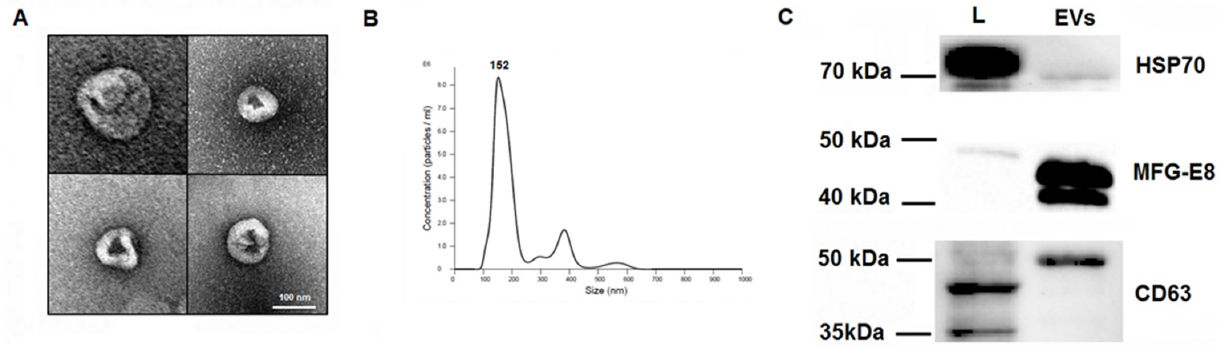
Figure 1. Characterization of extracellular vesicles (EVs) isolated from stem cells from the dental pulp of human exfoliated deciduous teeth (SHEDs). ( A ) Transmission electron microscopy of EVs isolated from SHEDs (120,000x magnification). ( B ) Concentration and particle size of EVs derived from SHEDs as analyzed by nanoparticle tracking analysis using a NanoSight LM10 instrument (Malvern Panalytical). Size distribution of the EVs was around 150 nm. ( C ) Samples from the cell lysates (L) and extracellular vesicles (EVs) were subjected to electrophoresis, blotted, and the membranes probed with antibodies against Hsp70, MFG-E8 and CD63. Bands were visualized by incubation with appropriate horseradish peroxidase-conjugated secondary antibodies and chemiluminescence substrate. Full blots are available in the Supplementary Figures S1–S3.